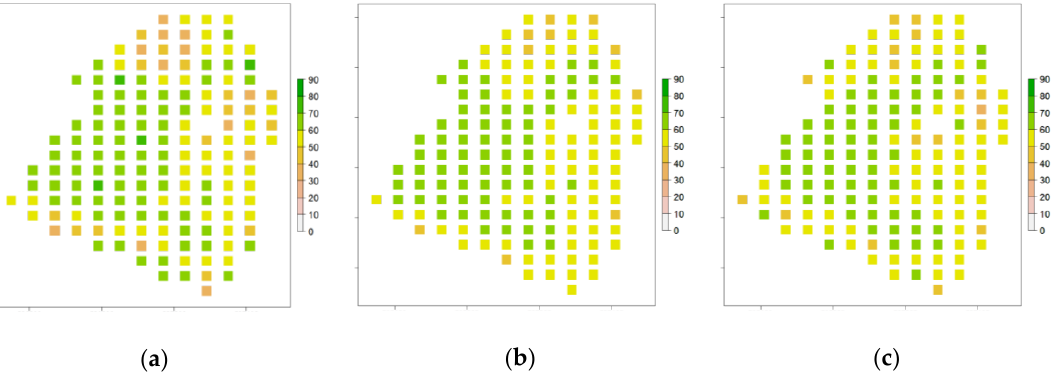
Figure 7. Maps of yield (expressed in q.ha − 1 ) collected in 2017 ( a ), and estimated using multi-temporal NDVI derived from images acquired from the sowing to the month of April (04 / 06 / 2017) ( b ) or the combination of satellite data and previous observed yields (collected during the agricultural season 2015) ( c ) on a plot dedicated to the cultivation of wheat.